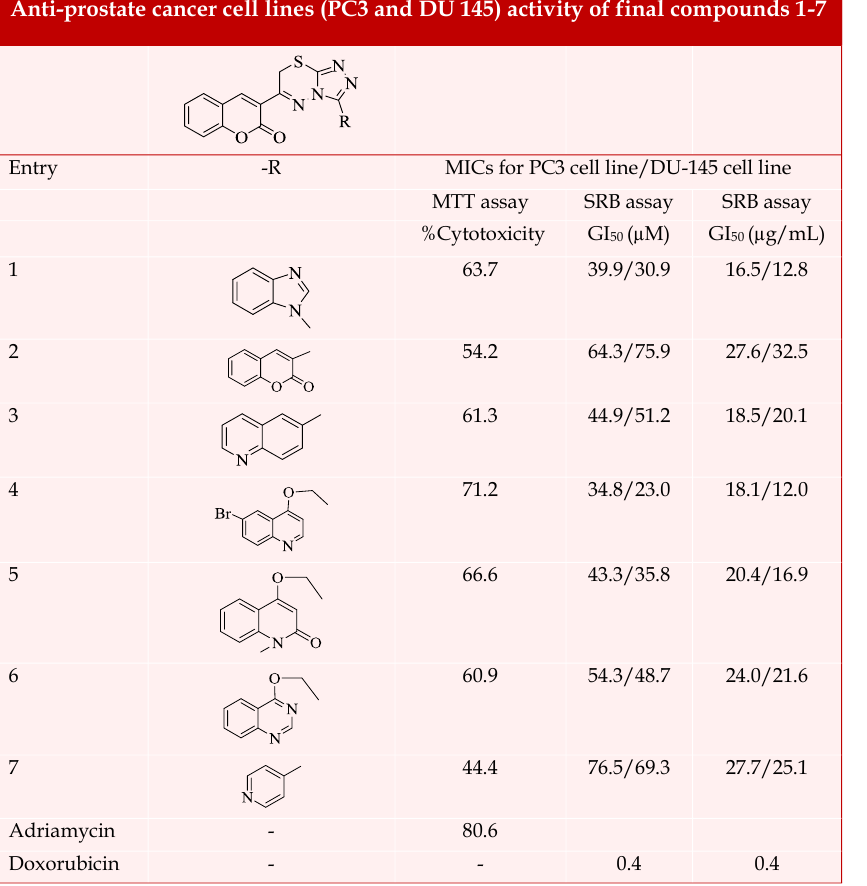
Anti-prostate cancer cell lines (PC3 and DU 145) activity of final compounds 1-7